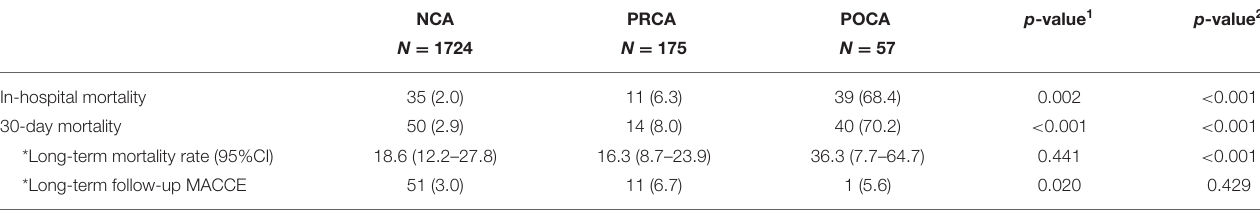
TABLE 3 | Cumulative mortality in patients with AMI stratified by timing of SCA.